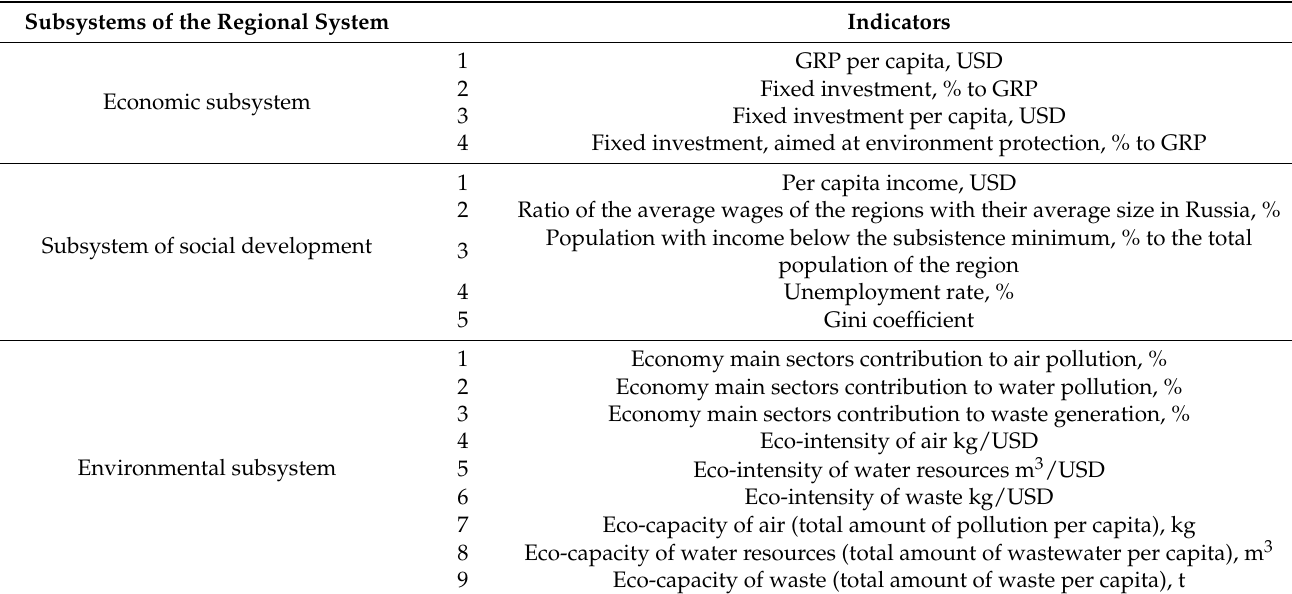
Table 3. Indicators for calculating the composite indicator.